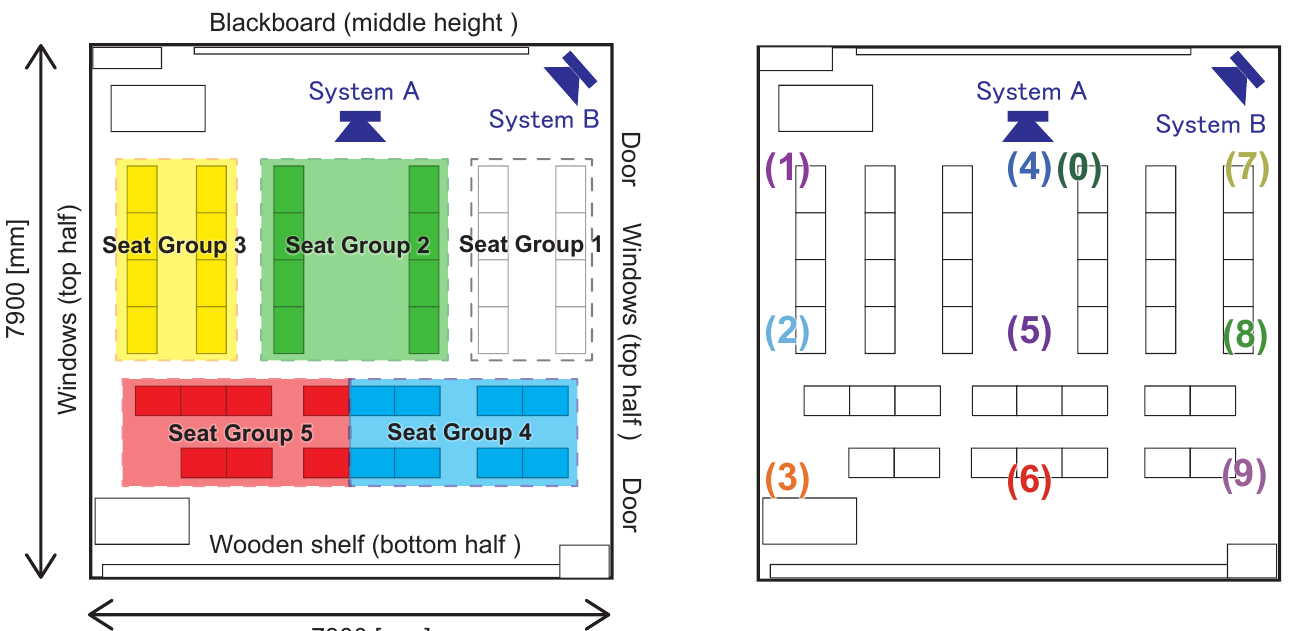
Figure 3. Layouts of the English room with positions of two sound amplification systems: ( left ) with dimensions and colour coded seat groups, and ( right ) with 10 measurement points, shown as numbers in